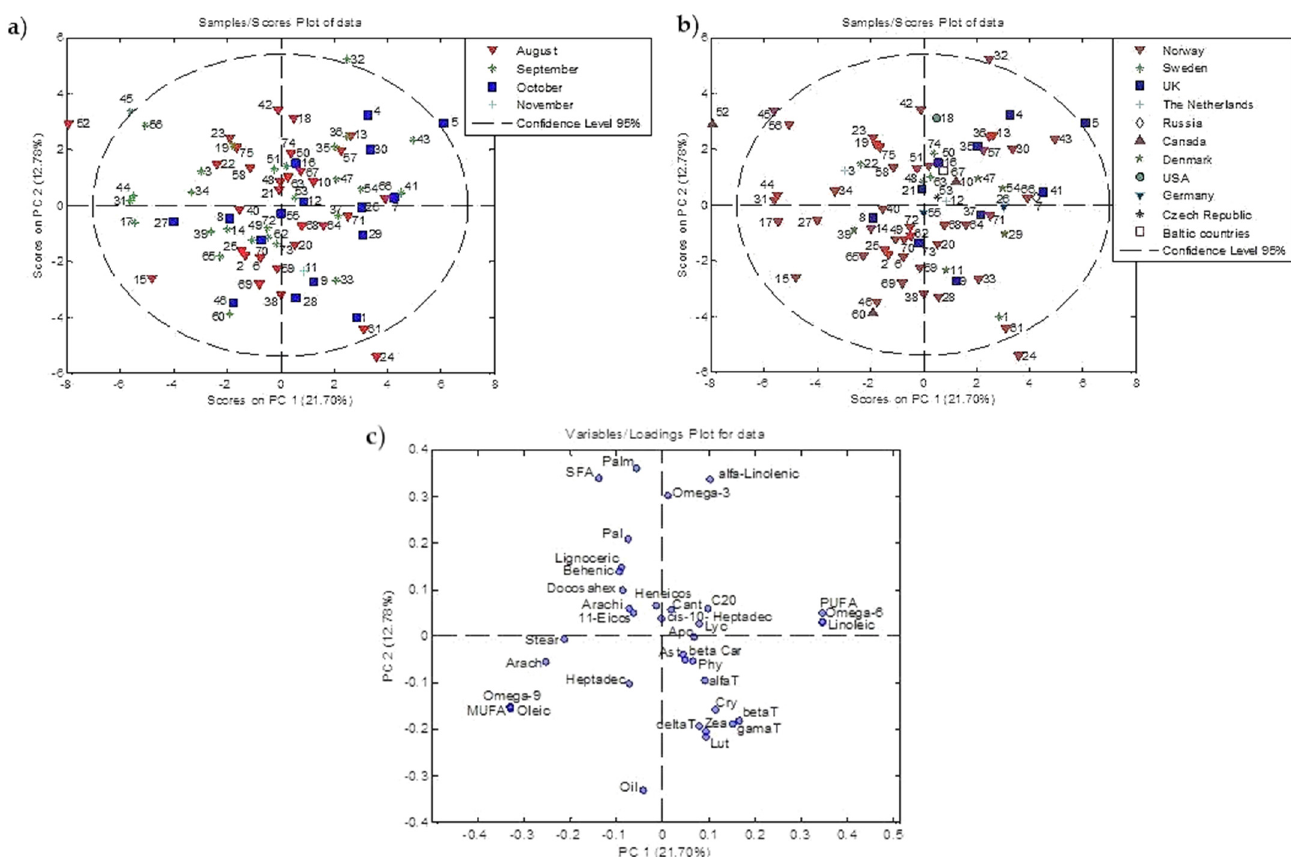
Figure 4. PC1 − PC2 Score plots. ( a ) The classes are marked based on ripening time; ( b ) The classes are marked based on country of origin; ( c ) Loading plot. Please see the Appendix A for the list of abbreviations.